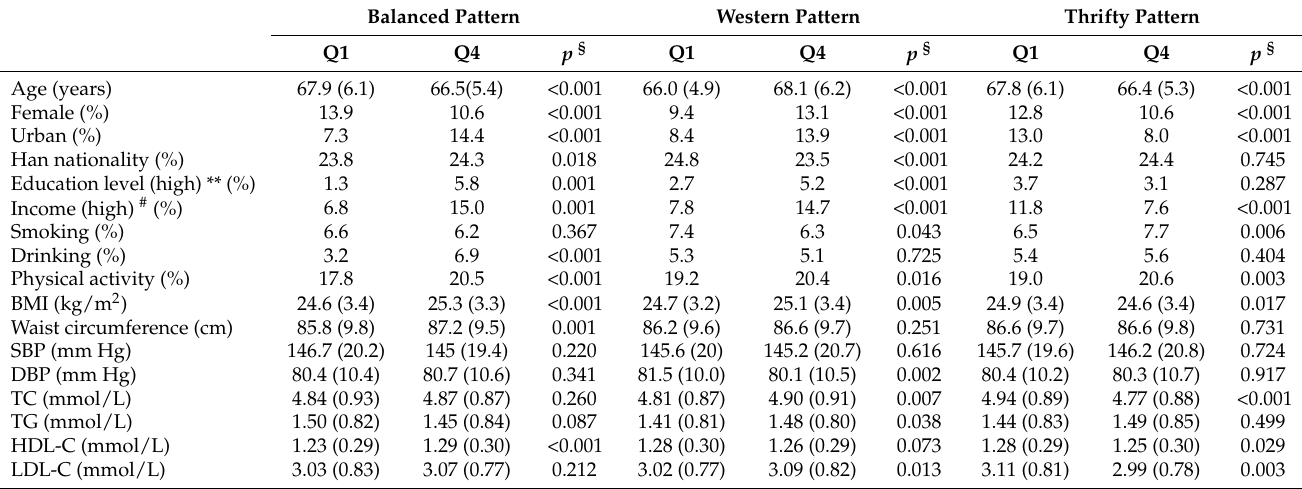
Table 3. Characteristics of older participants according to quartiles of the three dietary patterns *. Balanced Pattern Western Pattern Thrifty Pattern Q1 Q4 p §